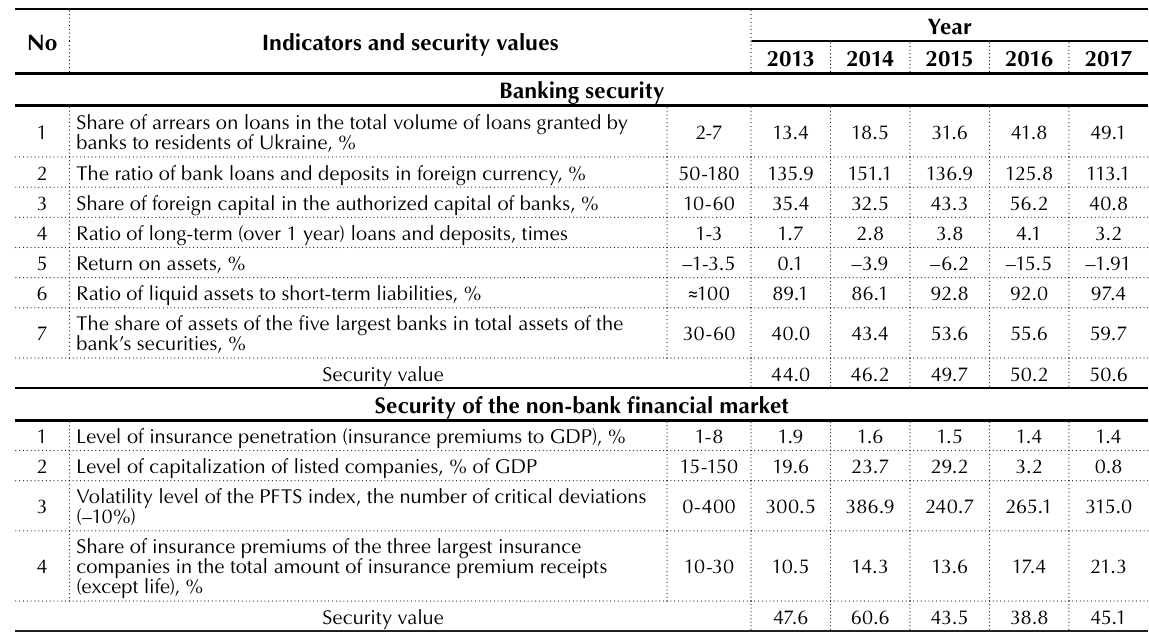
Table 1. Indicators of banking security and security of the non-bank financial market of Ukraine in